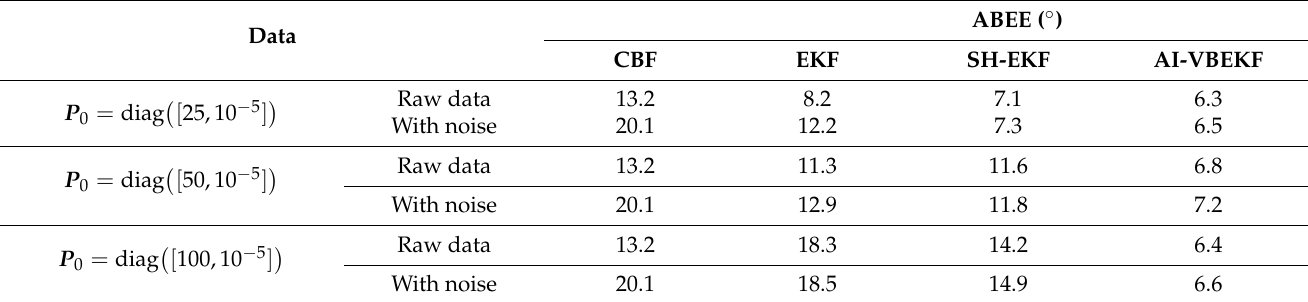
Table 3. ABEEs of different DOA tracking methods under different initial